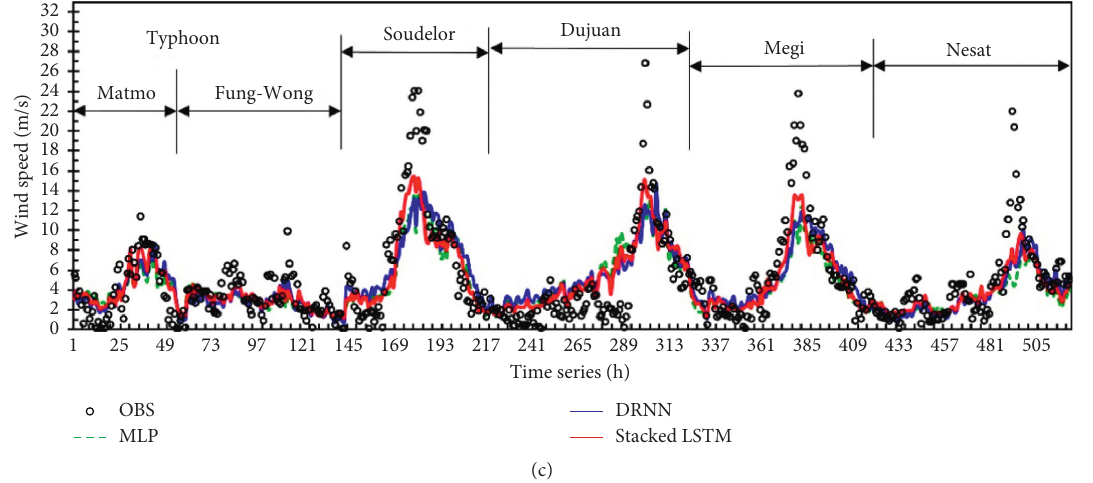
Figure 11: Predicted results of testing typhoons (2014–2017) on the Yilan gauge for the lead times of (a) 1 h, (b) 3 h, and (c) 6h.